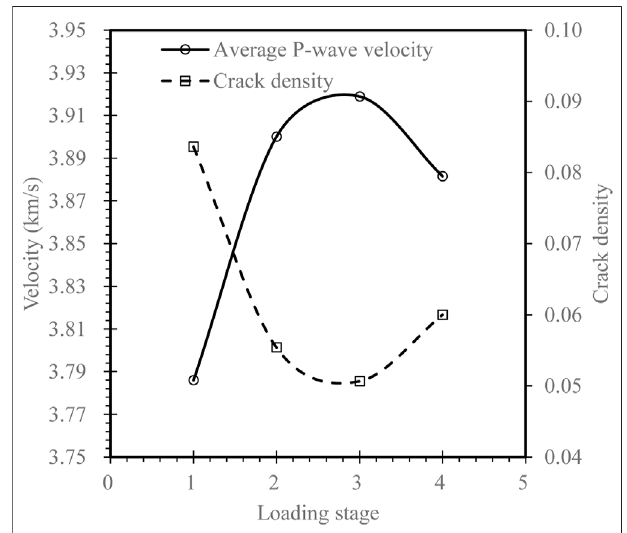
FIGURE 7 | Changes of the average velocity and the inverted crack density in the Brazilian